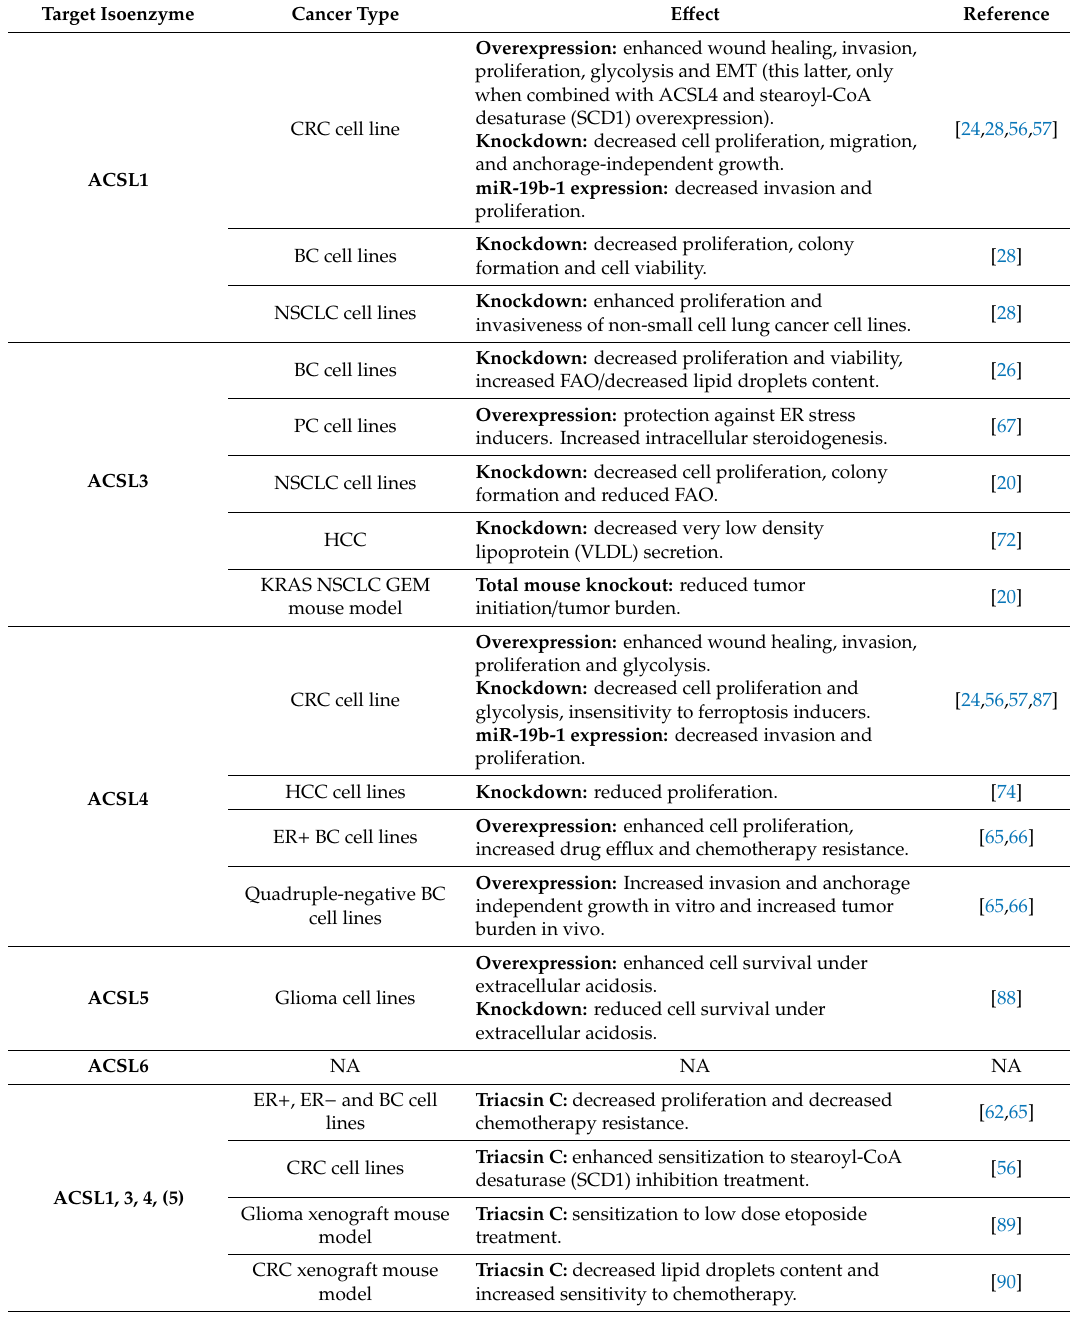
Table 1. Impact of the deregulation of ACSL isoenzymes in cancer models. Target